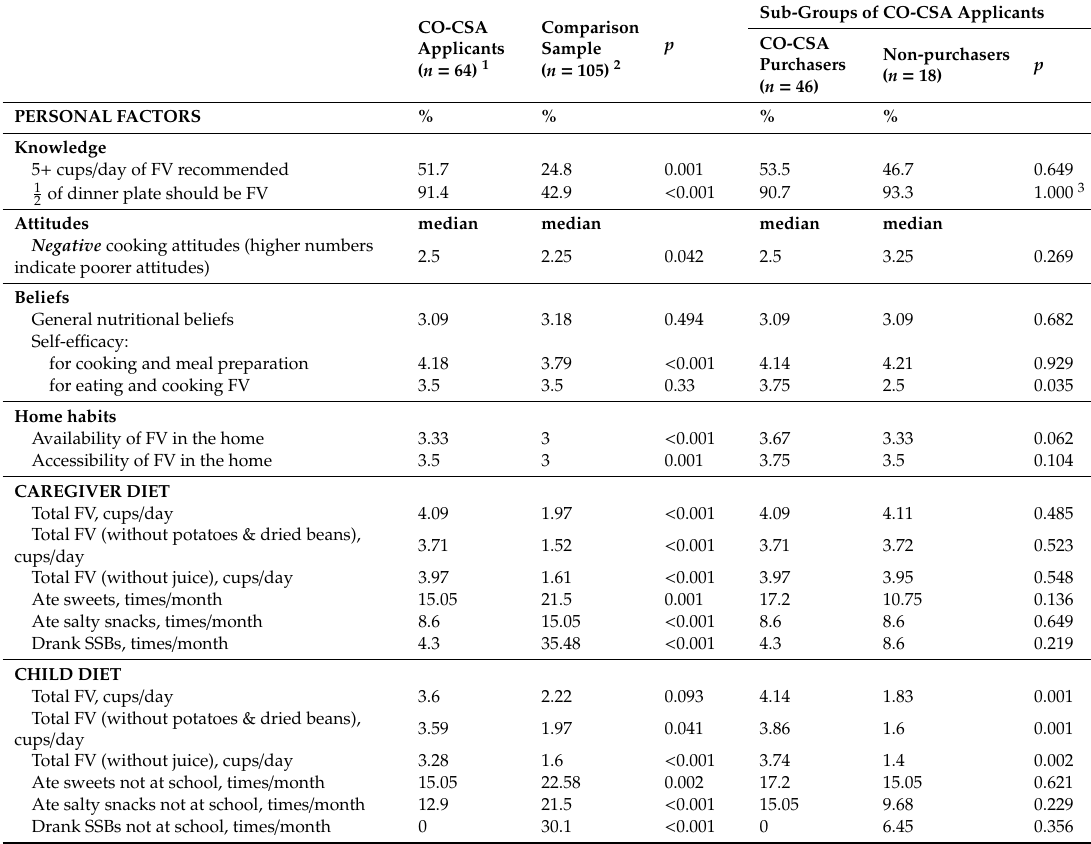
Table 2. Personal factors and dietary quality among low-income applicants to a CO-CSA program ( n = 64) and a comparison sample ( n =